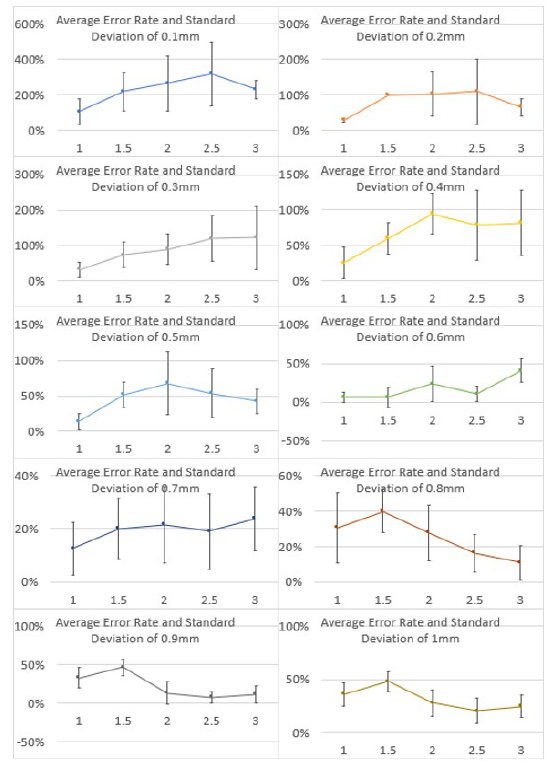
Figure 12. Individual charts of average error rate with standard deviations for each crack. 4.4.3 Automatically Detected Crack Dimensions: The